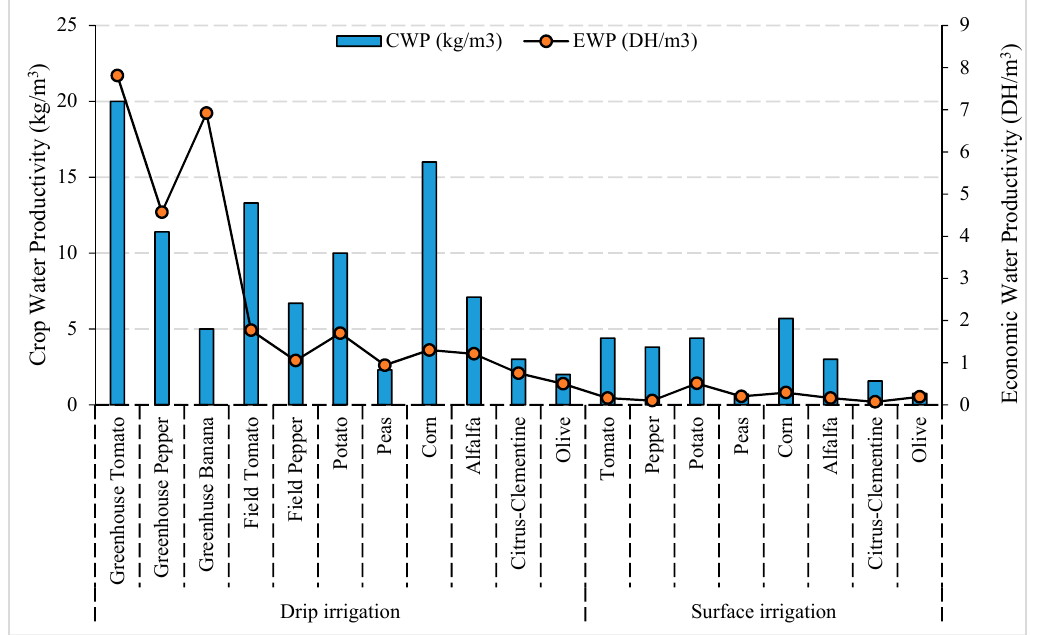
Figure 9. Economic (EWP) and crop water productivity (CWP) for the main crops cultivated under two types of irrigation systems (drip and surface irrigation) in the Souss–Massa region [39].